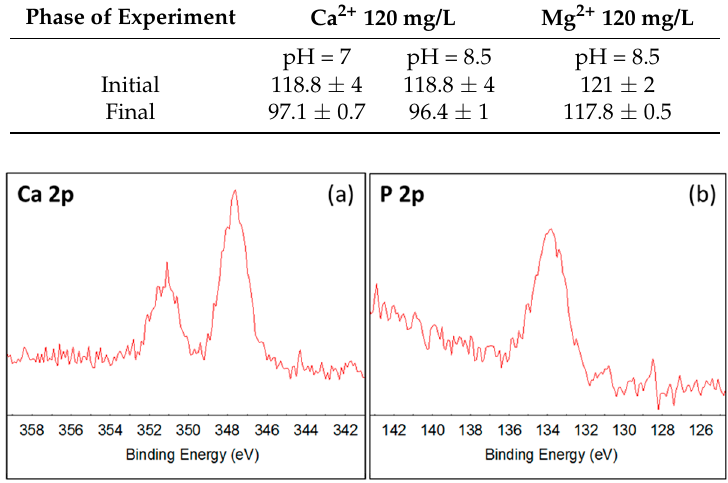
Table 1. Concentrations of Ca 2+ and Mg 2+ during the photocatalytic experiment.